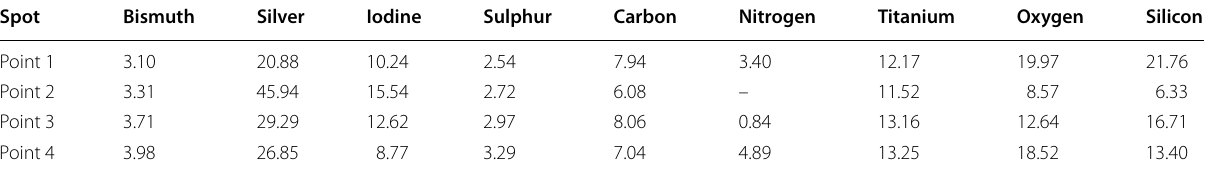
Table 10 Elemental distribution (atomic %) of the individual elements observed on Ag in Fig. 8c